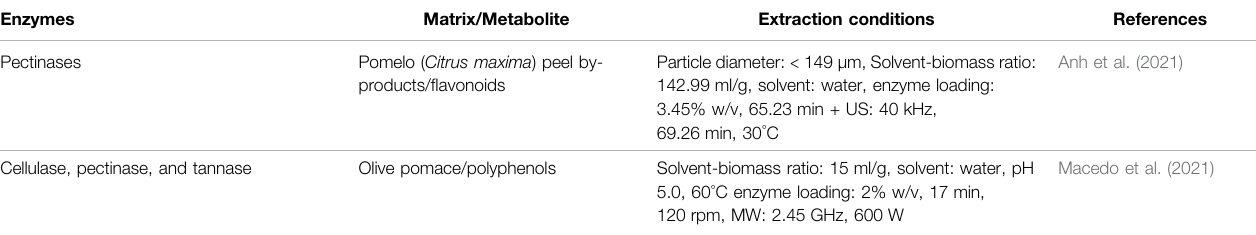
TABLE 1 | ( Continued ) Examples of enzyme-assisted extraction of bioactive compounds from agroindustrial